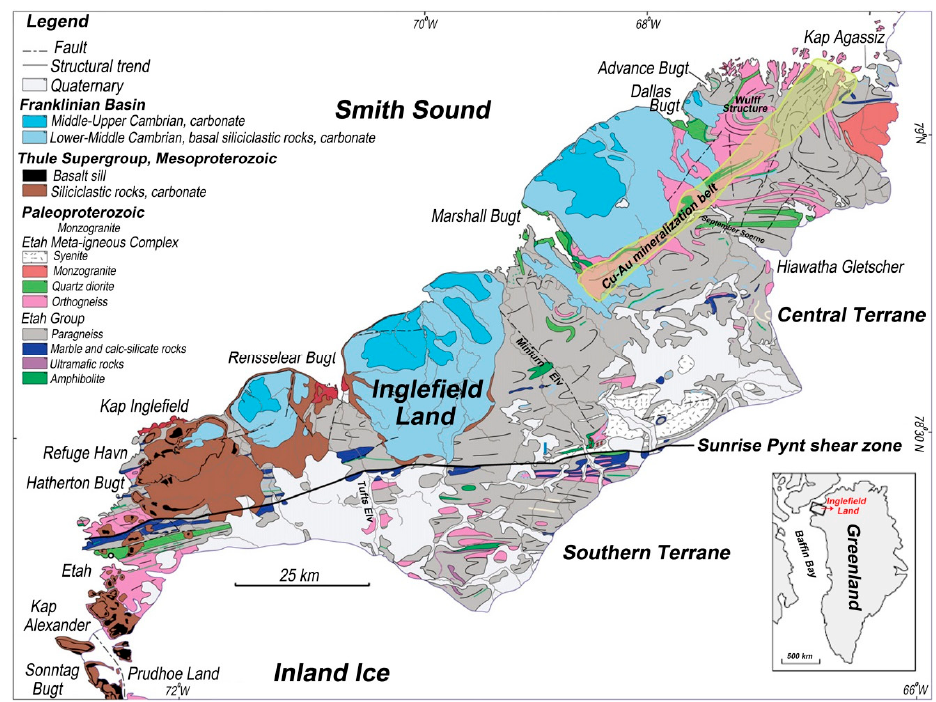
Figure 1. Geological map of the Inglefield Land. Cu-Au mineralized belt in the northeastern part of Inglefield Land shown as a yellow color semi-transparent polygon (modified after [3,42]).